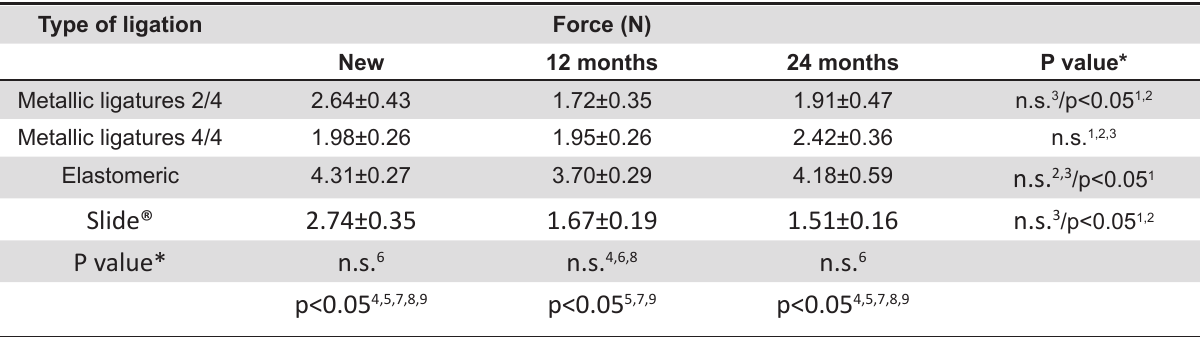
Table 1- Mean and standard deviations of the static friction during sliding tests. Comparison between different types of ligation and duration of intraoral bracket use